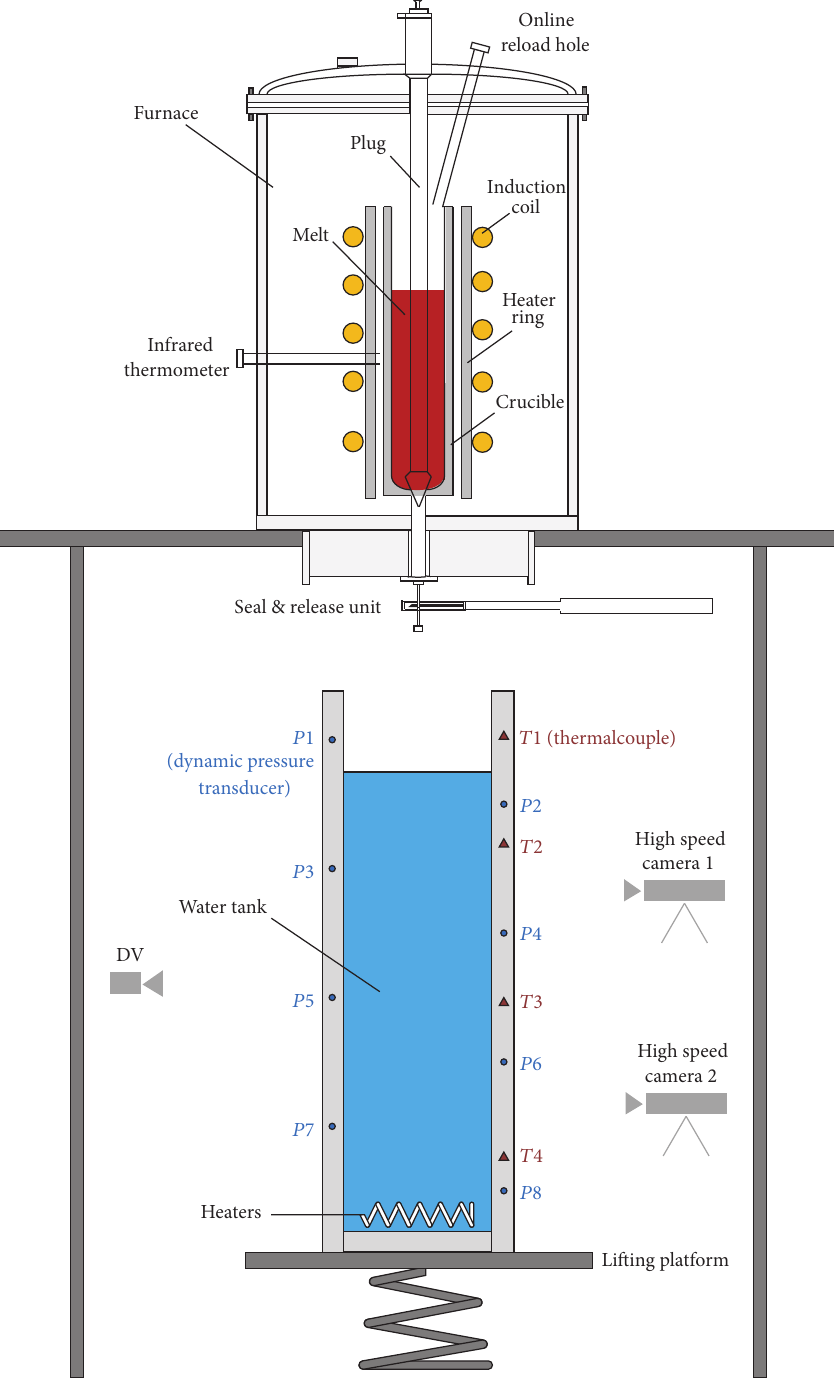
Figure 1: Schematic diagram of METRIC